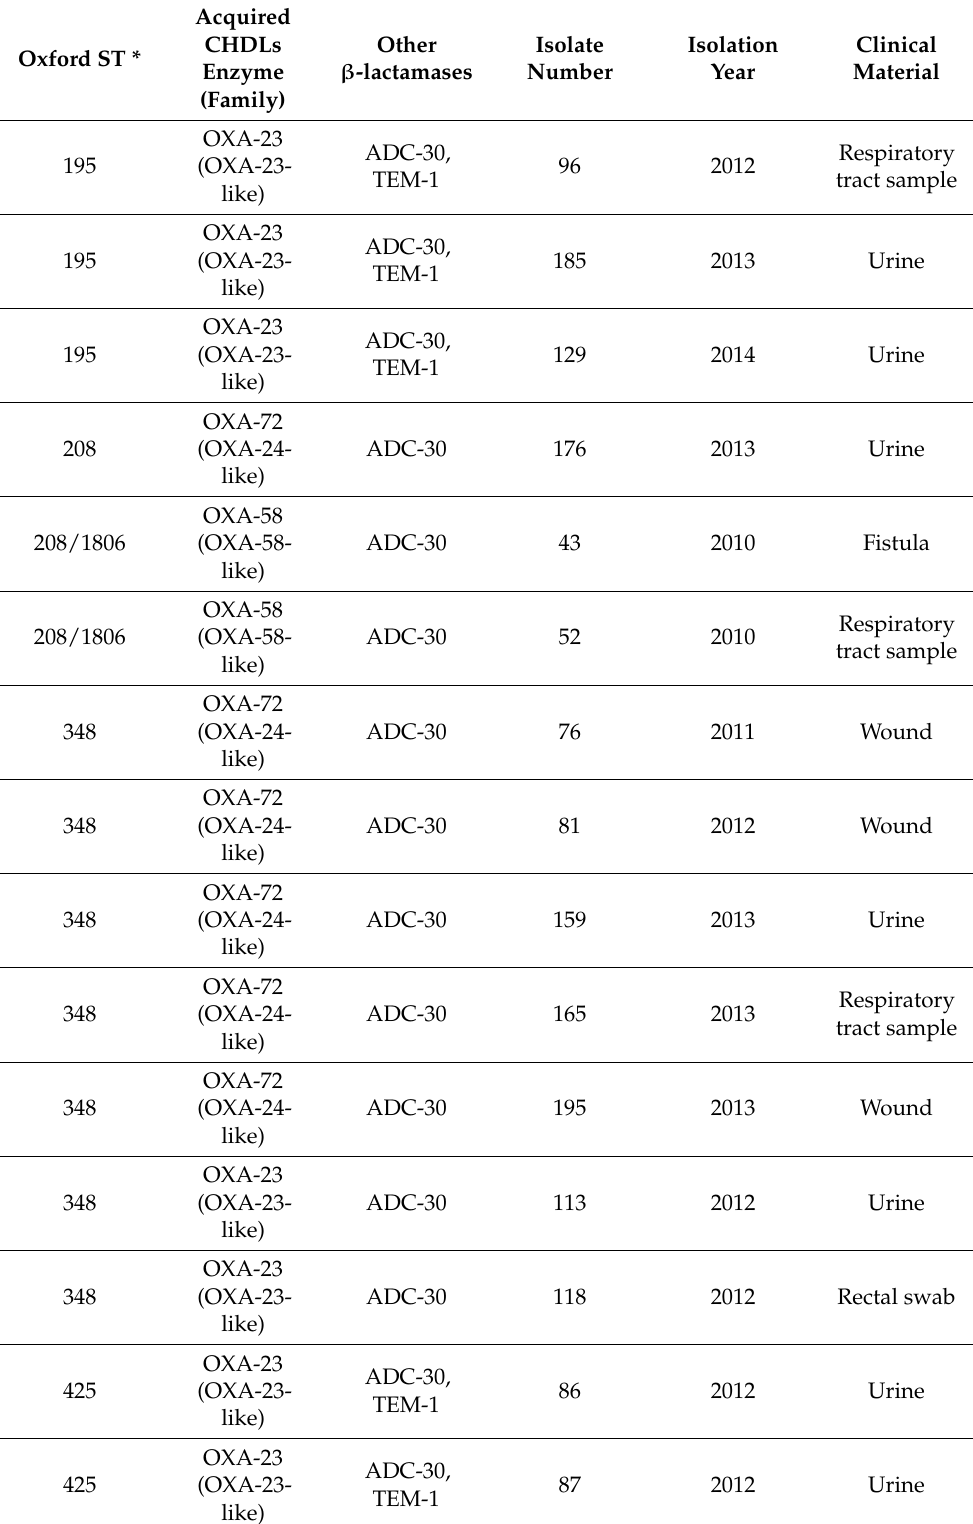
Table 3. Sequence types, β -lactamases and epidemiological data of the whole genome sequenced A. baumannii isolates ( n =